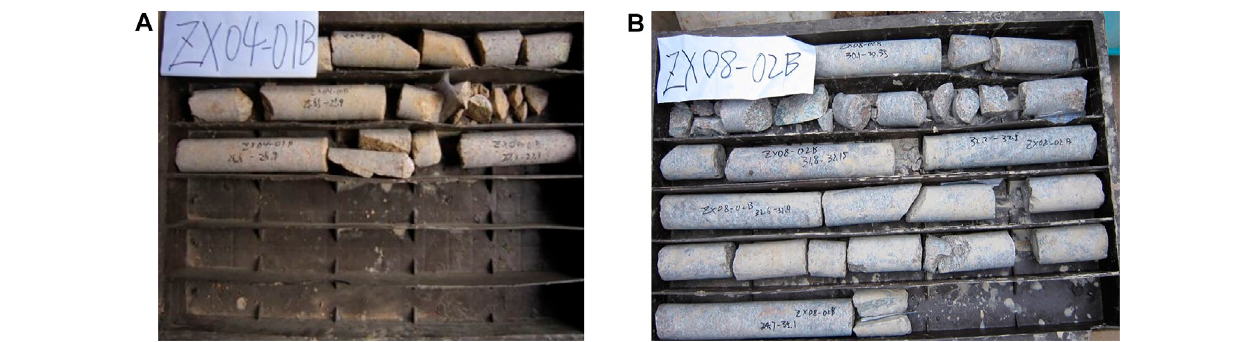
FIGURE 2 | Rock drilling and sampling. (A) Zhongshan Park Station; (B) Fushansuo Road Station.